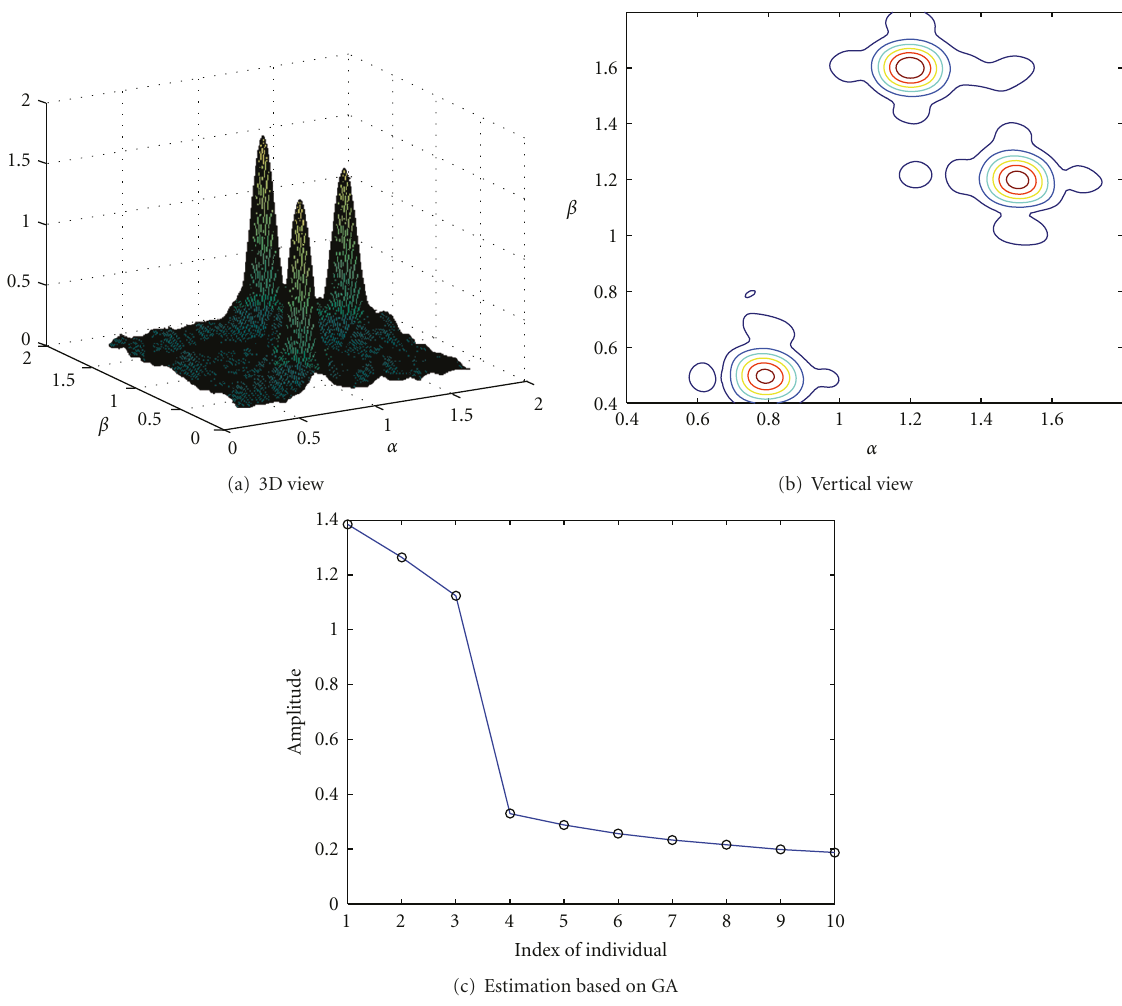
(cid:18) M α , β ) | of (7), e ( m , n ) is white Gaussian noise, SNR = 0 Figure 1: | 4 x (